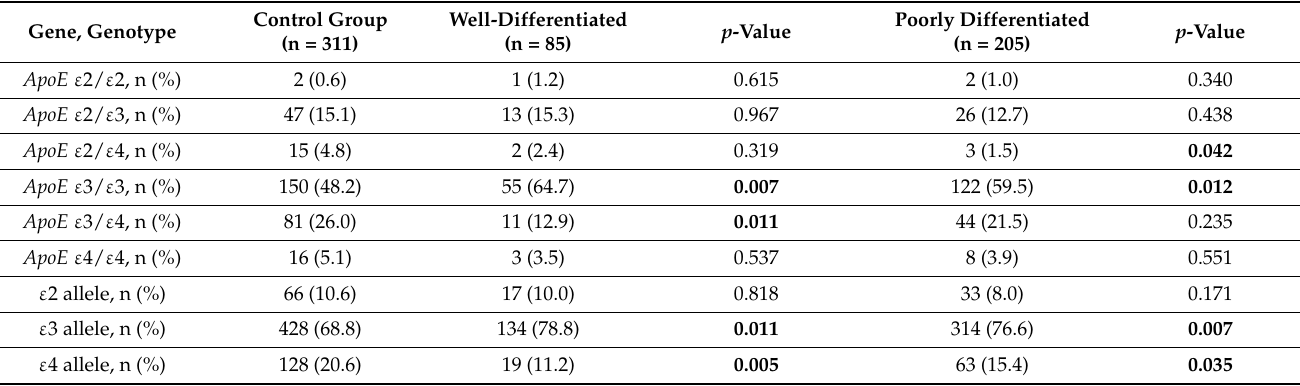
Table 10. Frequencies of ApoE genotypes and alleles in the healthy control group and LSCC patient subgroups with different tumor differentiation